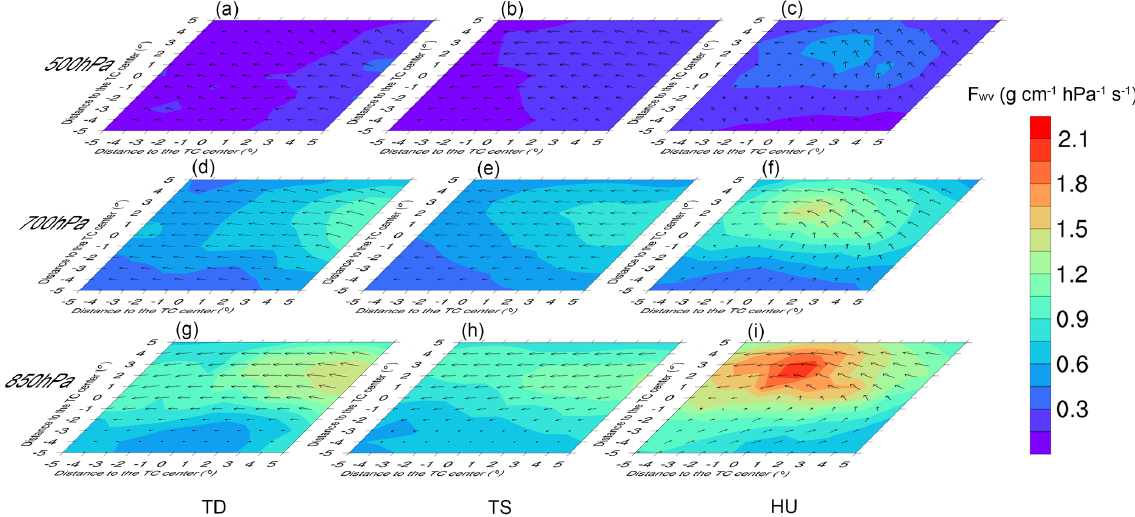
Figure 6. Water vapor fluxes and wind fields on different isobaric surfaces of TD, TS, and HU, respectively, with (a–c) 500hPa, (d–f) 700hPa, and (g–i)